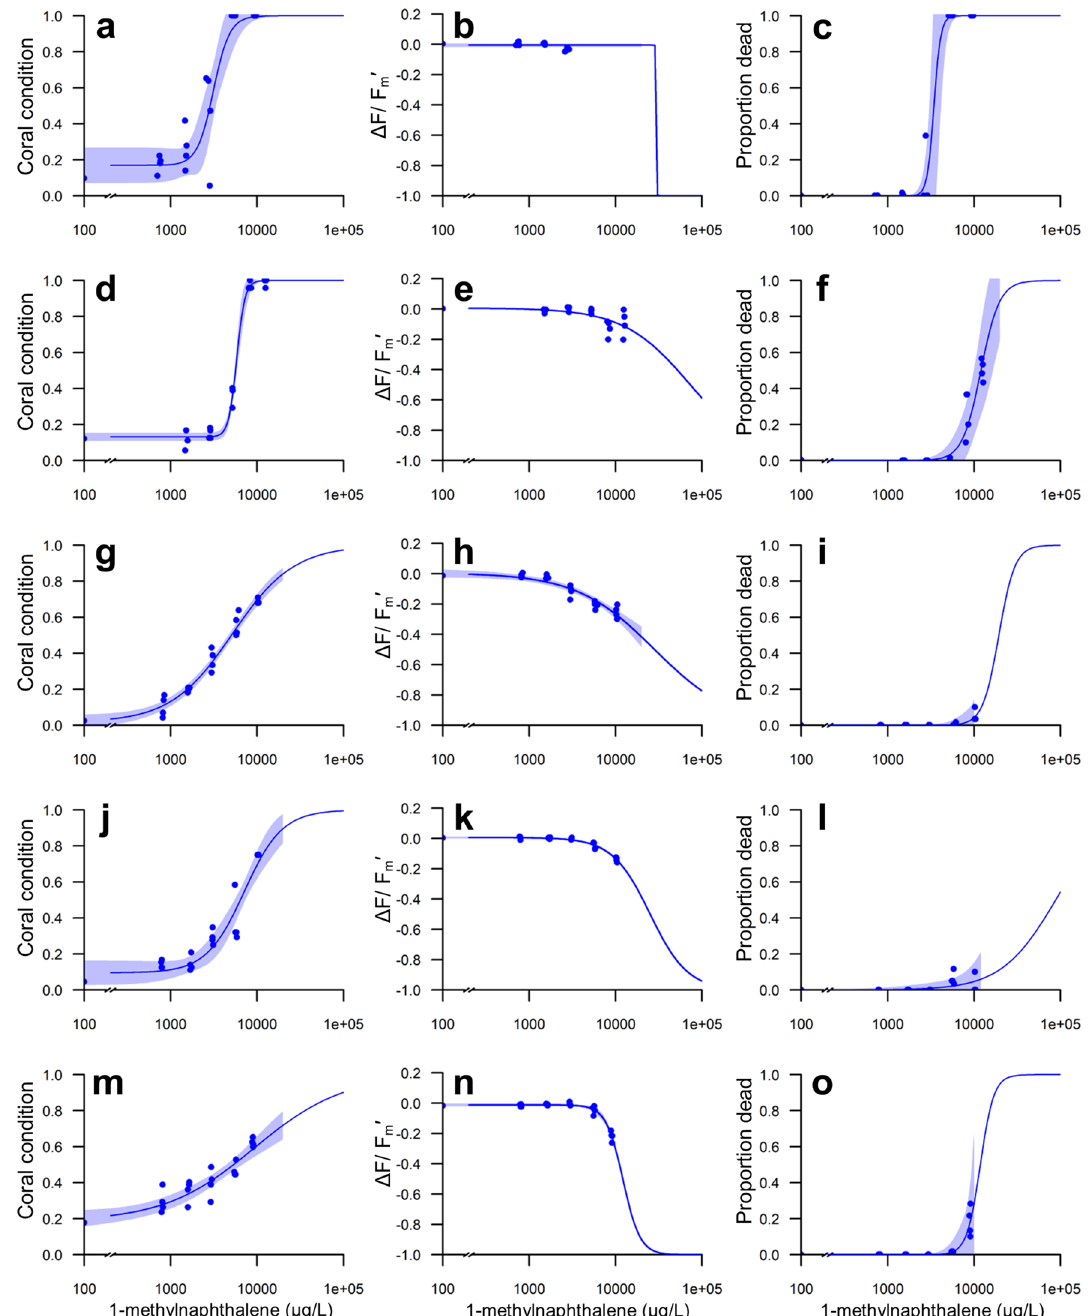
Figure 5. Dose–response curves for the effects of 48 h 1-methylnaphthalene exposure on coral condition (left column), light-adapted effective quantum yield (ΔF/F m ′ ) (middle column), and mortality (right column). ( a – c